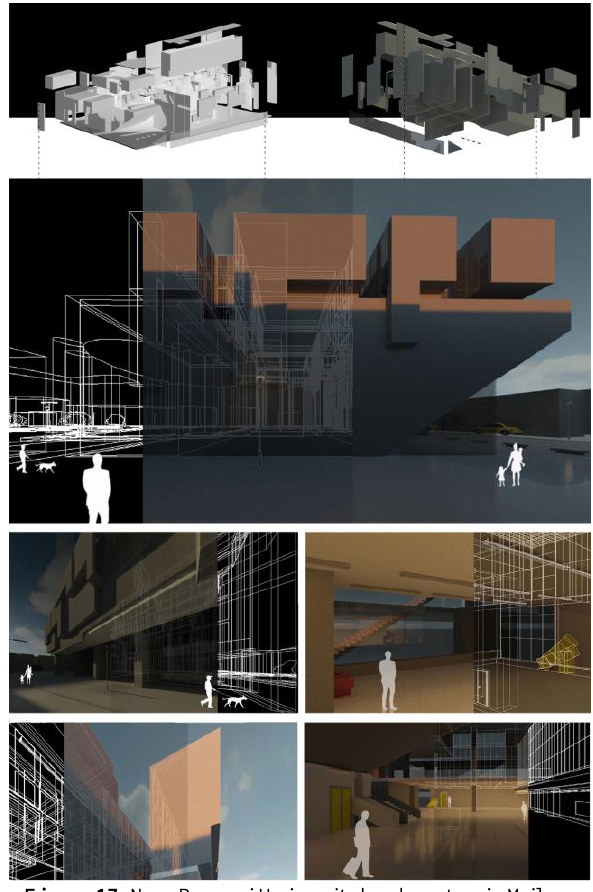
Figure 17 . New Bocconi University headquarters in Milan - Grafton building in via Röntgen (2008). Digital Metamorphosis, Communicative models of Resilience, Spatial compartment of objects and decomposition of the line-force. Brera Academy of Fine Arts Milan (A. De Masi).  “ Light effects connected to chiaroscuro ones ” for the visual rendering of shapes and profiles given by the